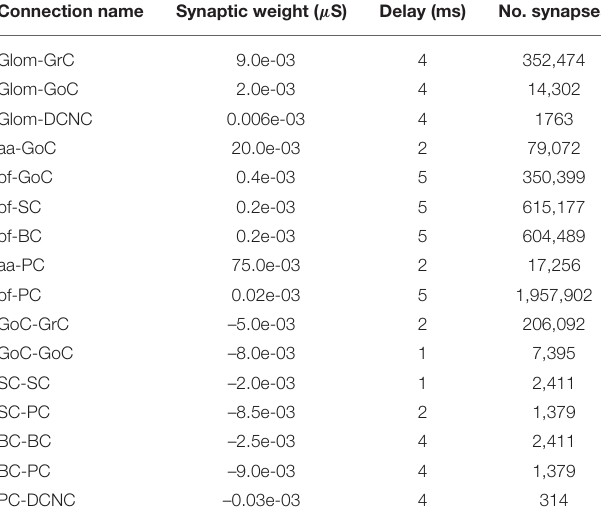
TABLE 3 | Connection